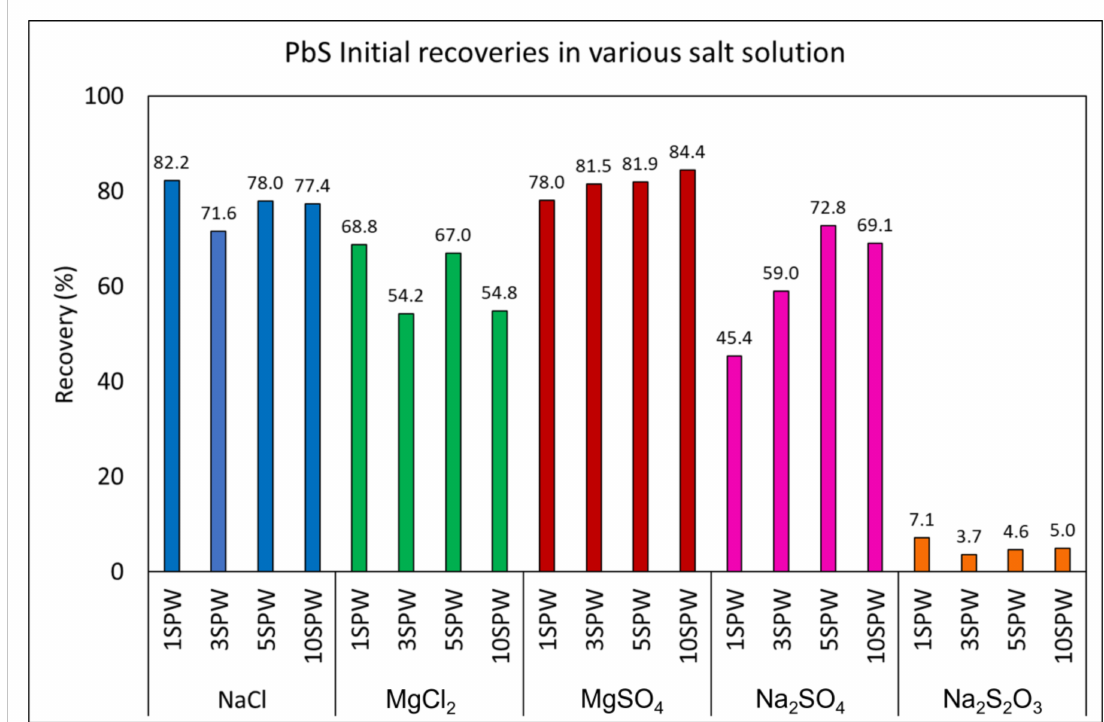
Figure 4. PbS 1st concentrate recovery in single salt solutions at varying ionic